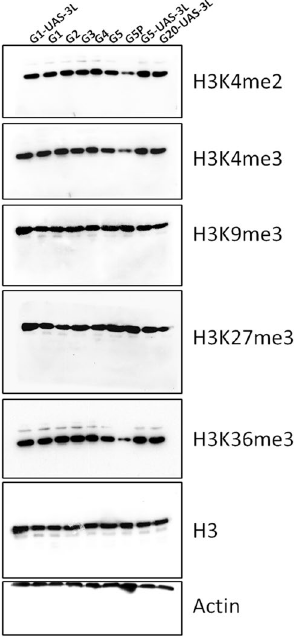
Figure 1. Western blot analysis for the various histone modification as indicated, performed on larvae from the various generations of control and DNMT3L expressing Drosophila larvae. G1-UAS-3L and G5-UAS-3L are control larvae without GAL4 driver from G1 and G5 generation respectively. G1 to G5-Tub-3L larvae from the indicated generation. G5P-G5 Tub-3L larvae that had melanotic tumors. G20-UAS-3L* denotes larvae from G20 generation after crossing out of the Tubulin-GAL4 driver. Actin was used as a loading